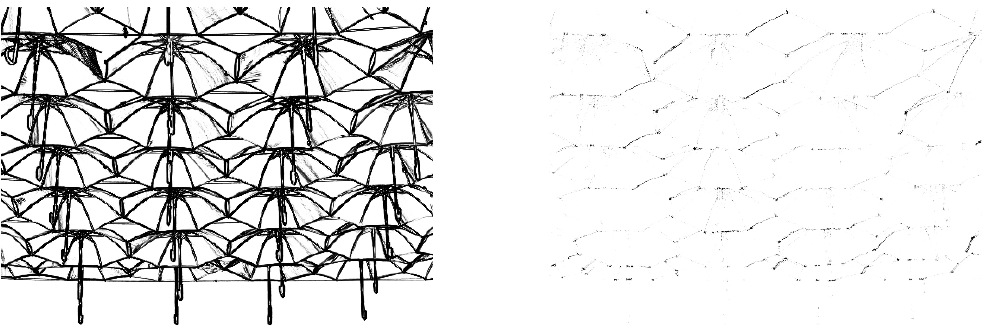
Figure 2. The diffusion coefficients 2 ∂ψ (cid:48) / ∂λ (cid:48) + ( left ) and 2 ∂ψ (cid:48) / ∂λ (cid:48) − ( right ) for one of the test